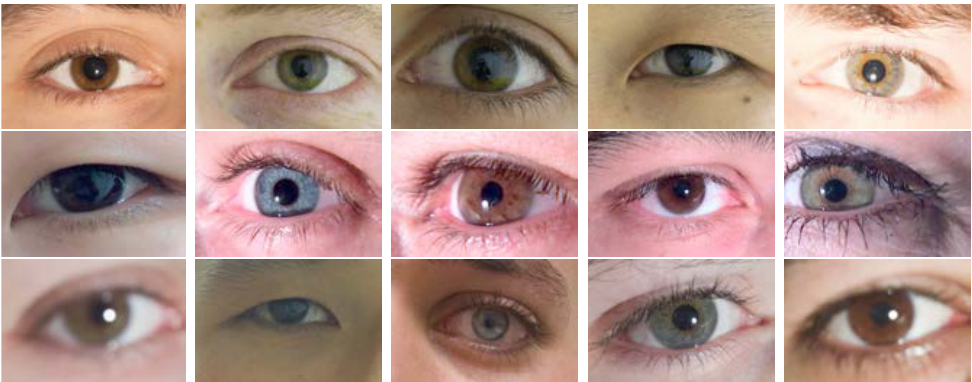
Figure 4. Some iris image samples with high, medium, and low pigmentation from the multi-modal biometric dataset GC 2 [36]. The first, second, and third rows show some images from the REFLEX, LFC, and PHONE datasets,